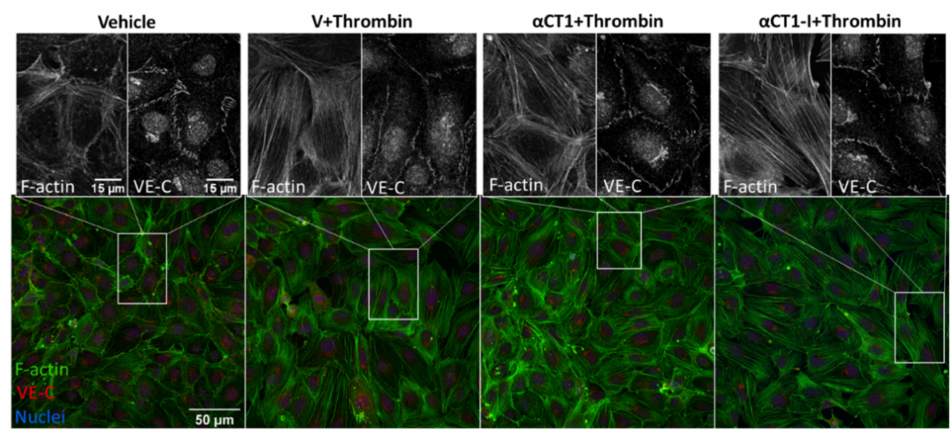
Figure 5. α CT1 inhibits thrombin-induced shift in endothelial F-actin and VE-cadherin distribution in HMEC-1 cell monolayers. Representative confocal images of F-actin and VE-cadherin in 100 µ M labeling in peptide-treated, HMEC-1 cells, fixed 5 min after thrombin addition to the media. Zoomed sections show representative treatment-induced F-actin and VE-cadherin